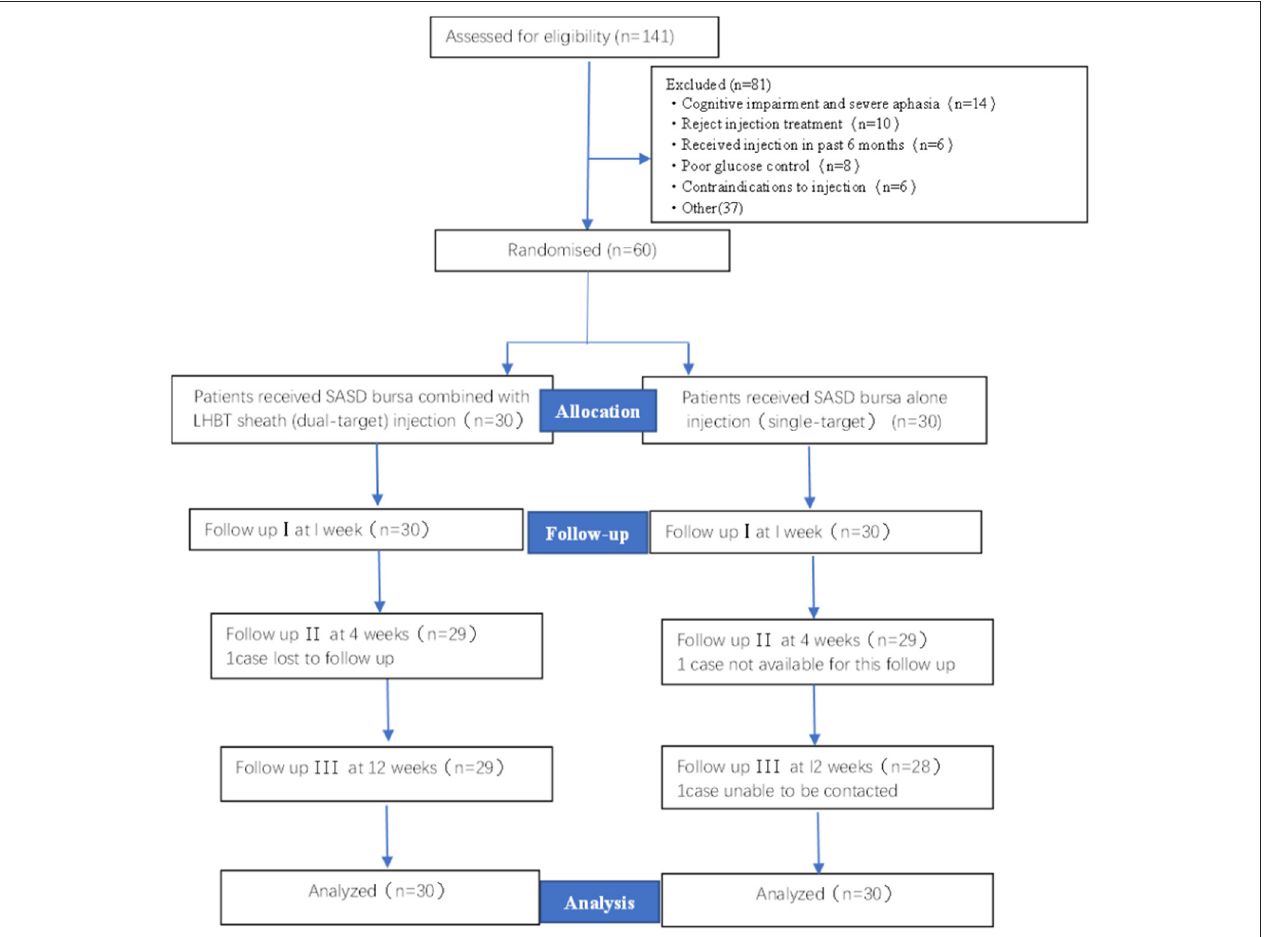
FIGURE 2 | Flow chart of study enrollment. SASD, subacromial-subdeltoid; LHBT, the long head of the bicep tendon.